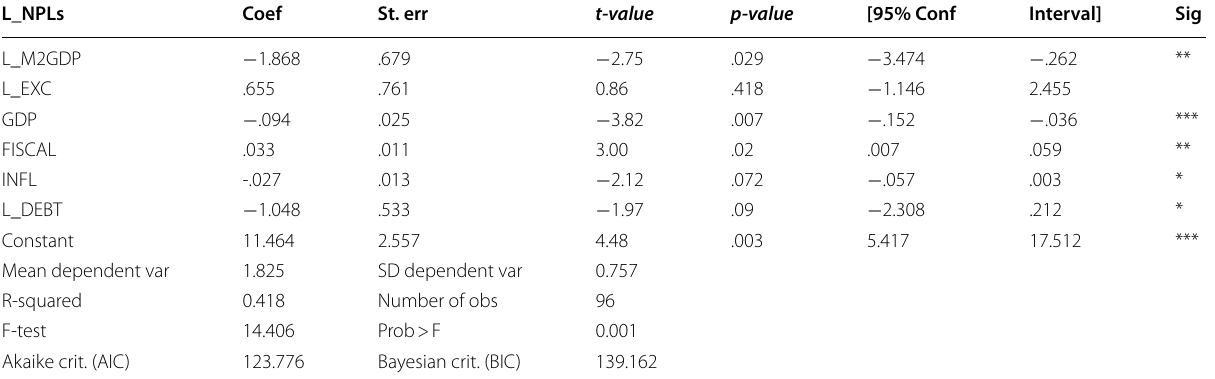
Table 6 Robust standard error fixed effect regression